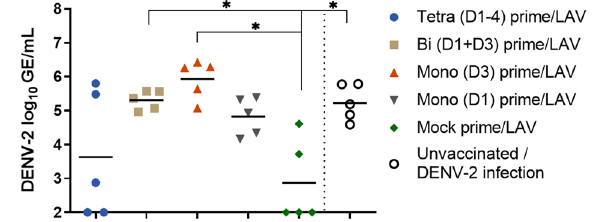
Fig. 5 Peak viremia for DENV-2 live-attenuated vaccine virus and wild-type challenge virus. Shown are the peak viremia values from each animal following LAV vaccination or the following wild-type DENV-2 infection of unvaccinated control animals. Data are presented as log 10 -transformed genome equivalents (GE)/mL. Horizontal bars are the geometric means for each group. Data were analyzed by Welch ’ s ANOVA model and Dunnett ’ s T3 multiple comparisons test. * p <